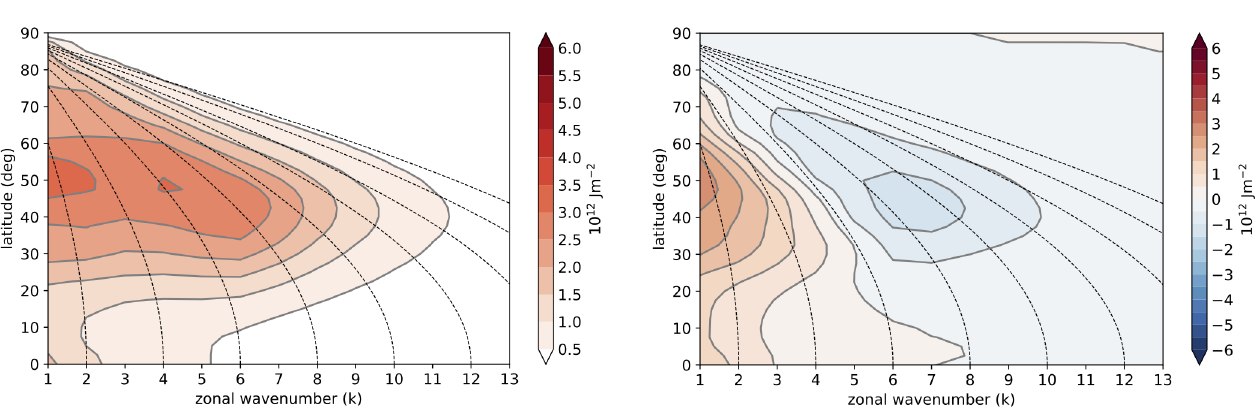
Figure 6. The eddy anisotropy metric M = (u (cid:48) 2 − v (cid:48) 2 )/ 2, presented in the same format as Fig.